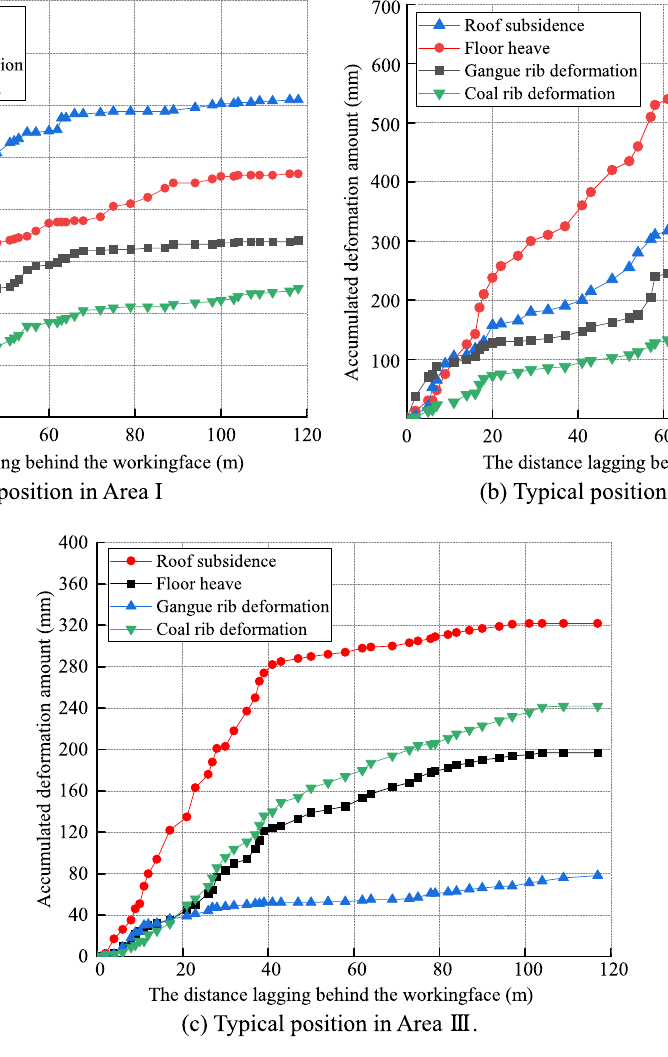
Figure 13. Deformation characteristics of the roadway surroundings in the three